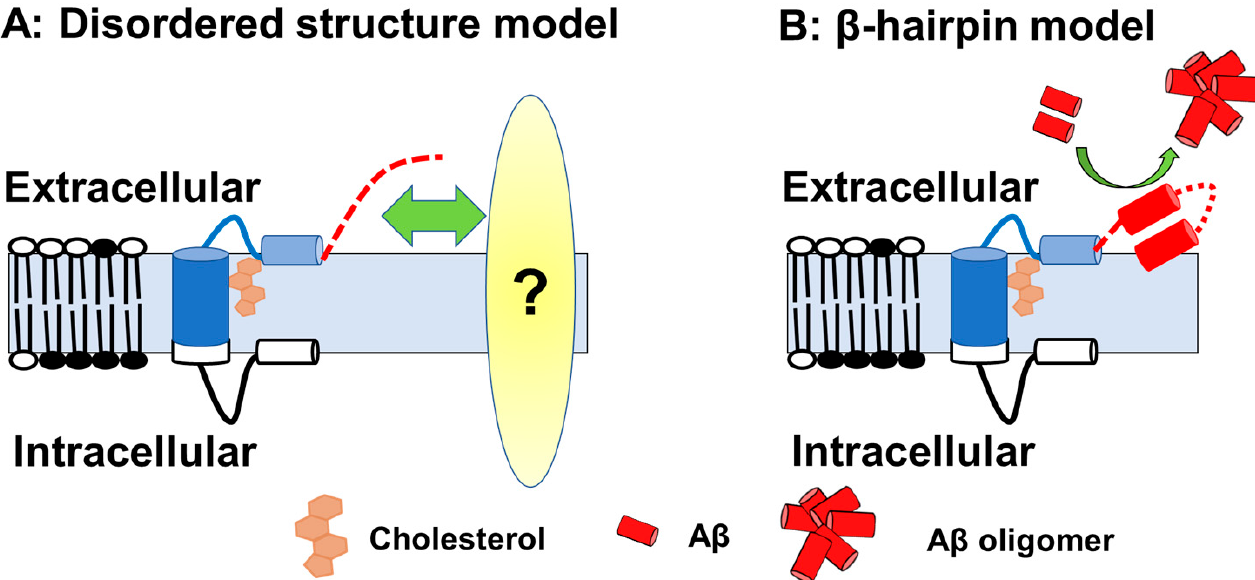
Figure 4. A schematic of the C99 structure. ( A ) Model with A β -Nt as the disordered structure; A β -Nt may bind to its partner molecule and exert specific functions. Red dotted line represented N- terminal structure. ( B ) Model assuming A β -Nt forms a β -hairpin. The β -hairpin structure formed may promote A β aggregation.